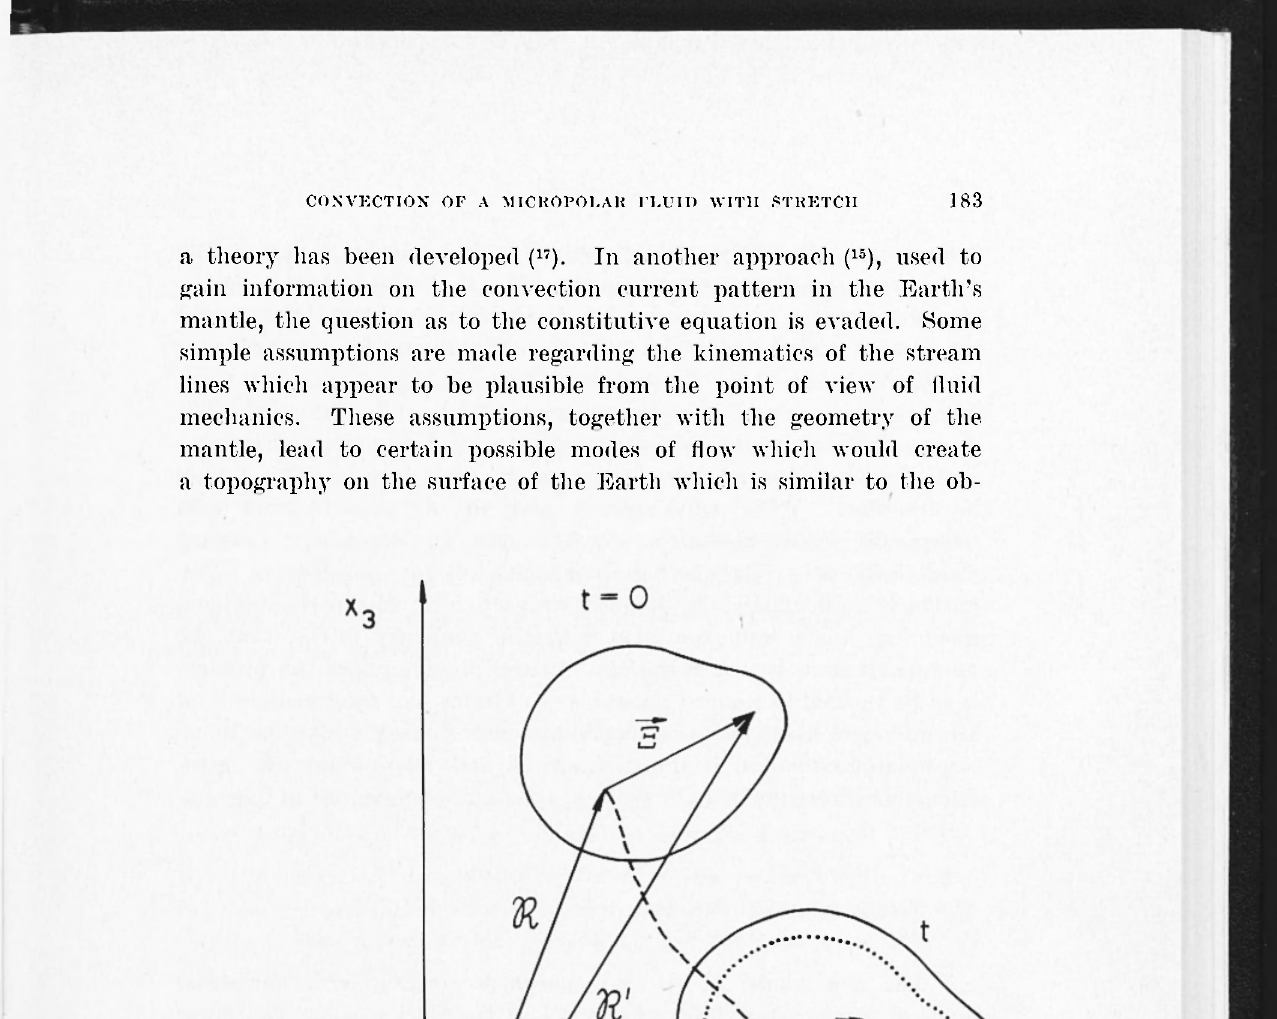
Fig. 2 - Translation, rotation and isotropic microstretcli of an element of a micropolar fluid with